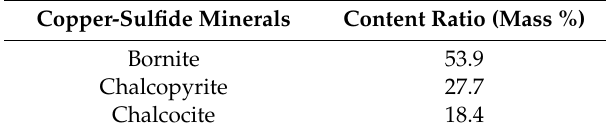
Table 4. Distribution of bornite, chalcopyrite, and chalcocite in the copper sulfides of the